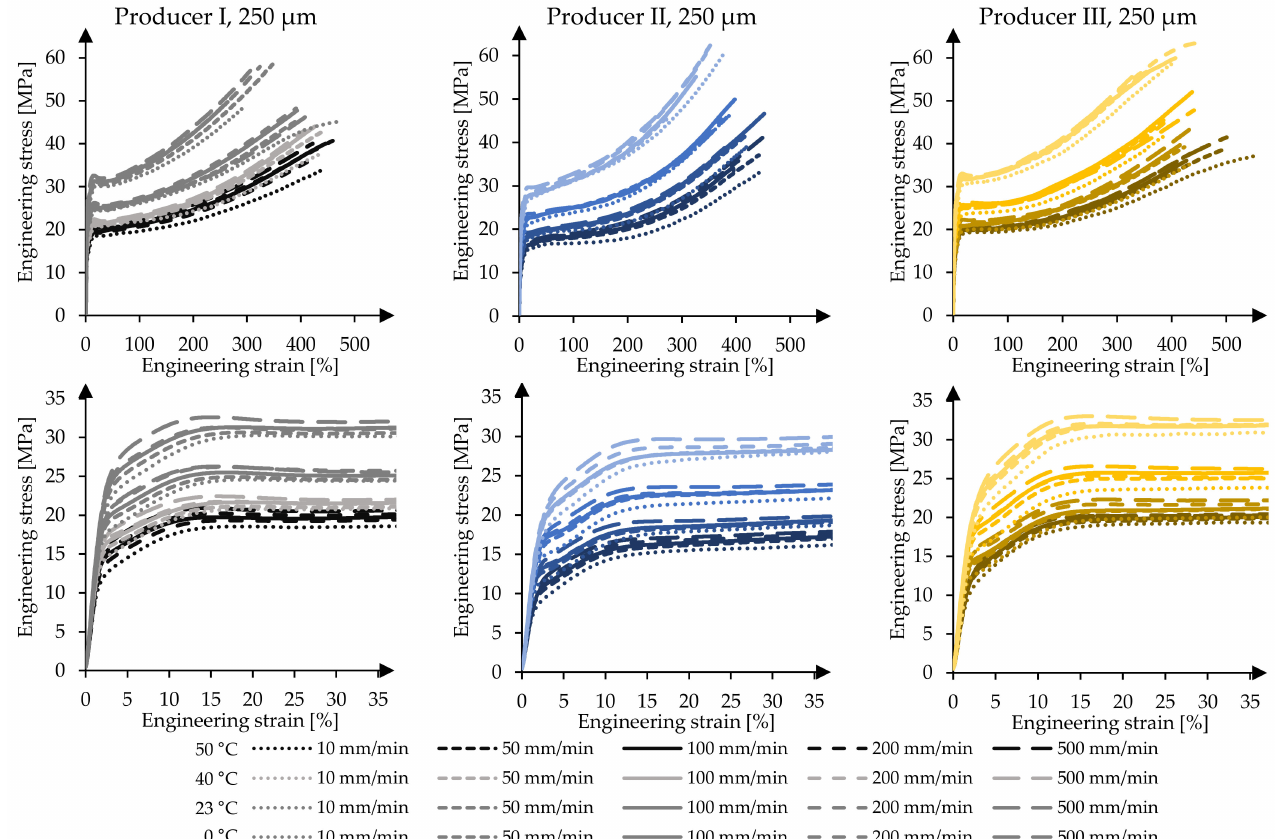
Figure 4. Mechanical response of 250 µ m ETFE foils in uniaxial tensile tests at varying test tem- peratures and test speeds as mean value curves per test series, for materials of producers I, II, and III,